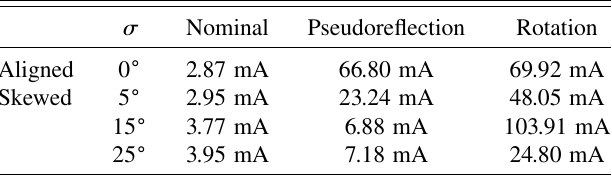
TABLE 2. Predicted threshold currents from two-dimensional BBU simulations where the standard deviation ( (cid:27) ) represents the shift in mode orientation from 0 (cid:1) and 90 (cid:1) .